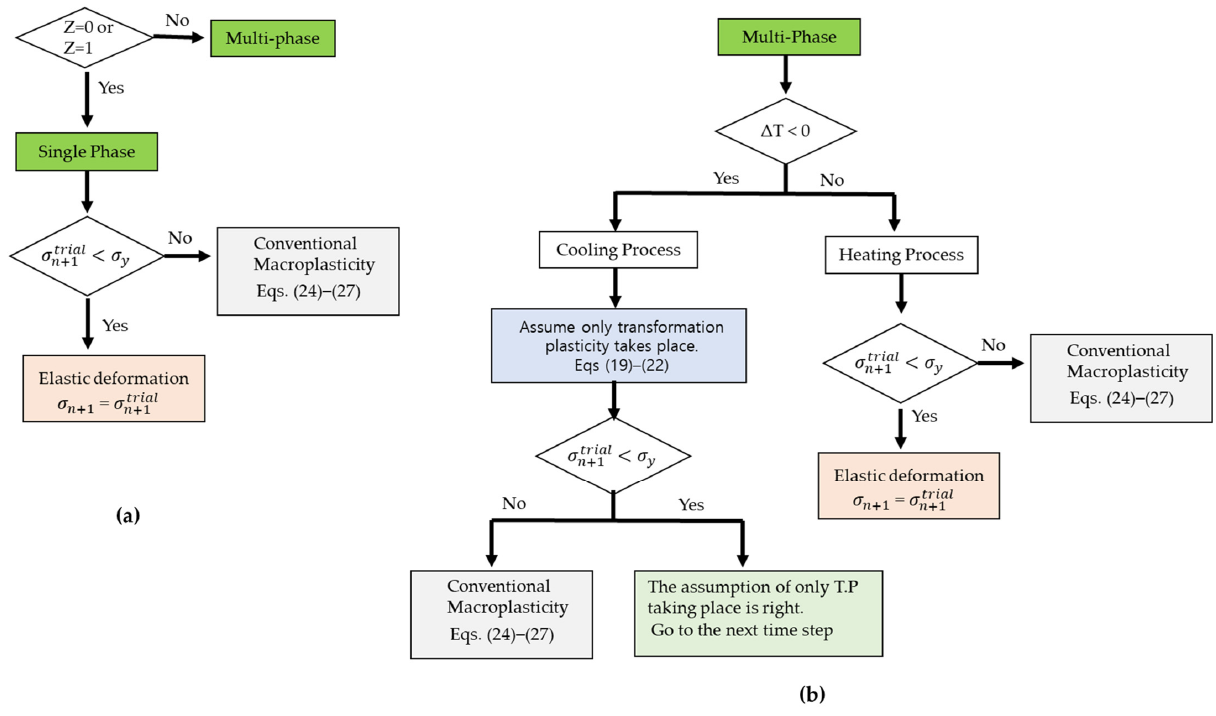
Figure 4. The stress-update process of the present numerical model. ( a ) single phase case; ( b ) multiple phase case.